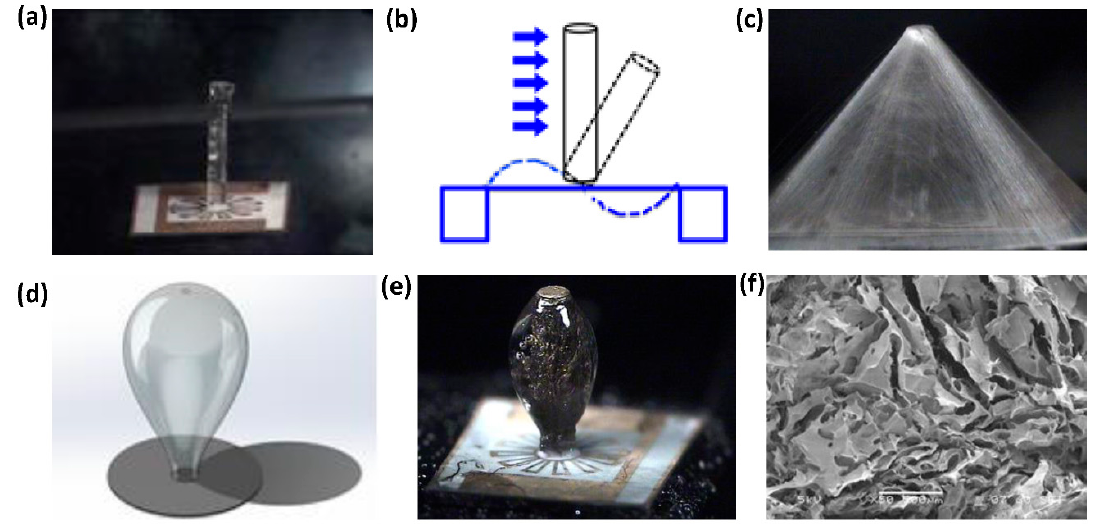
Figure 1. Superficial neuromast inspired steady-state flow sensor. ( a ) Photograph of LCP membrane with polycarbonate structure. ( b ) Schematic representation of the sensing mechanism. ( c ) Photograph of the electrospun nanofibril scaffold ( d ) Schematic representation of the SN cupula. ( e ) Photograph of the sensor with HA-MA hydrogel cupula. ( f ) SEM image of the cross-section of